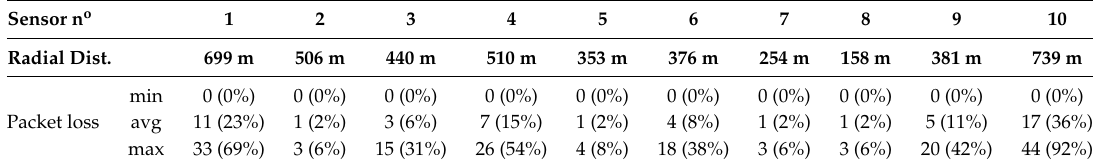
Figure 8. SNR observed on both LoRa and Sigfox sensor networks over a 2-month period. Table 2. Features of LoRa sensors and daily packet loss over a 2-month